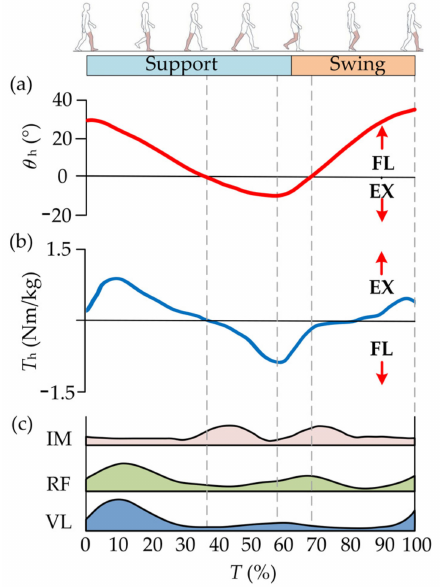
Figure 1. Kinematics and biomechanics of the hip joint. ( a ) When the hip joint moves to the absolute minimum angle (maximum extension), the thigh begins to flex forward and enter the early swing phase. ( b ) The flexion torque gradually increases with the forward flexion until the later stage of the swing phase. ( c ) The activations of the flexors are concentrated in the middle stage of the gait cycle